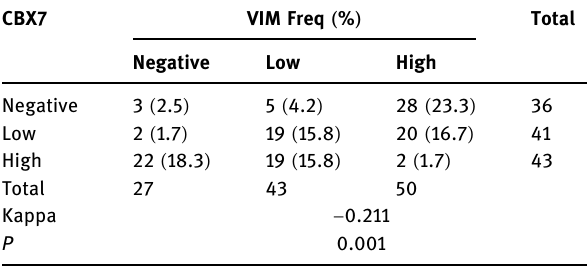
Table 5: Correlation between CBX7 and VIM